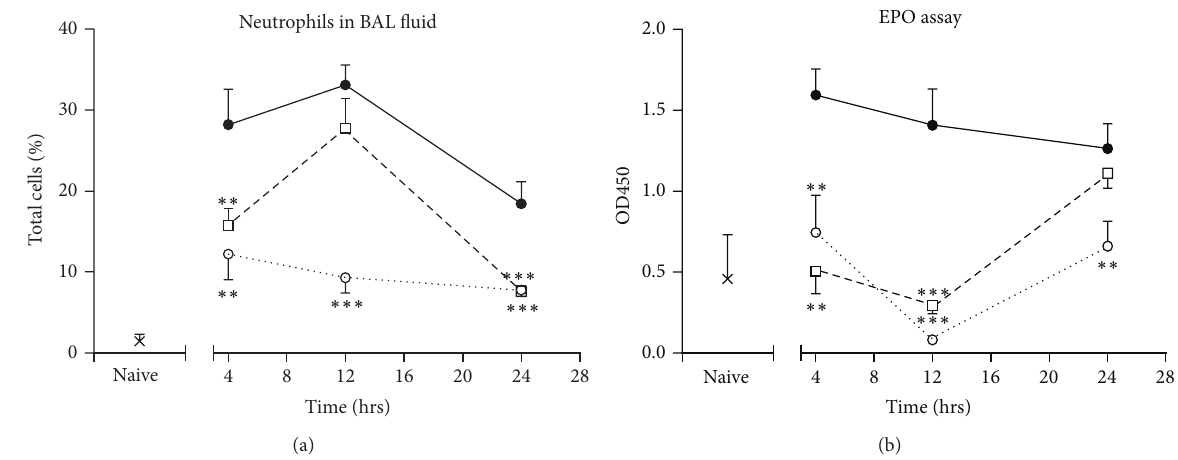
Figure 2: Effects of drug treatment when administered after an exacerbation of experimental asthma on (a) neutrophils in lavage fluid (b) eosinophils in lung tissue, assessed by colorimetric assay for EPO. Animals were treated with vehicle (— e —), ISU201 (-- ◻ --), or dexamethasone ( ⋅⋅⋅ I ⋅⋅⋅ ) at 2 and 8 hours after induction of an exacerbation. Data are mean ± SEM ( 𝑛 = 6 animals per group). Significant differences relative to vehicle-treated animals at each time point are shown as ( ∗∗ 𝑃 < 0.01 ) and ( ∗∗∗ 𝑃 < 0.001